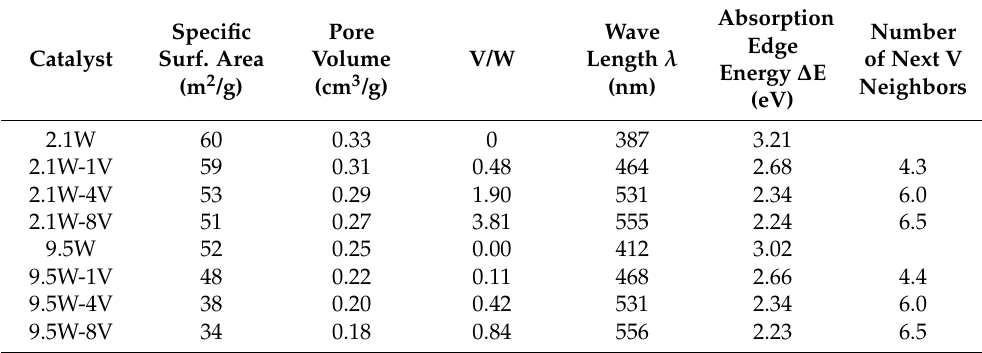
Table 5. Textural properties and spectral features extrapolated from UV-vis spectra recorded for V 2 O 5 -WO 3 /TiO 2